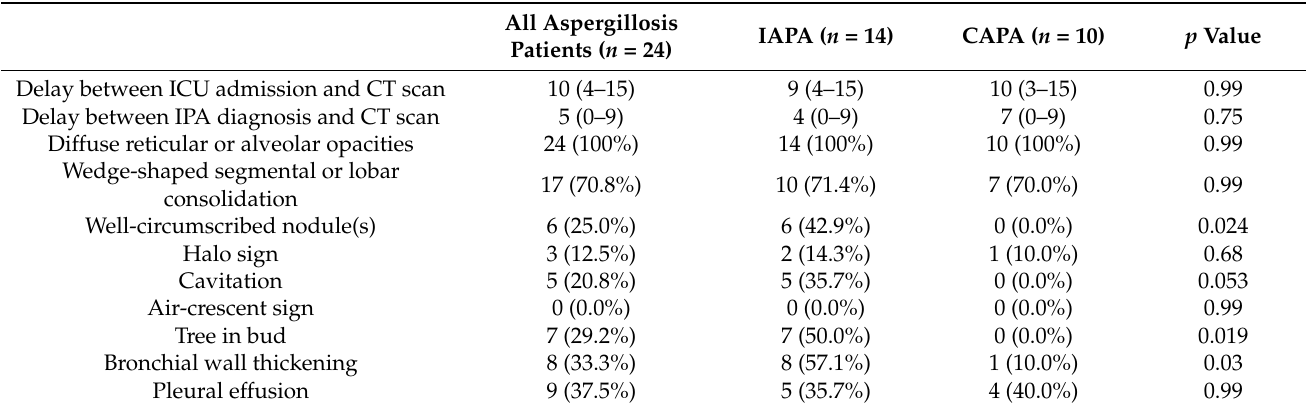
Table 3. CT-scan analysis of IAPA and CAPA